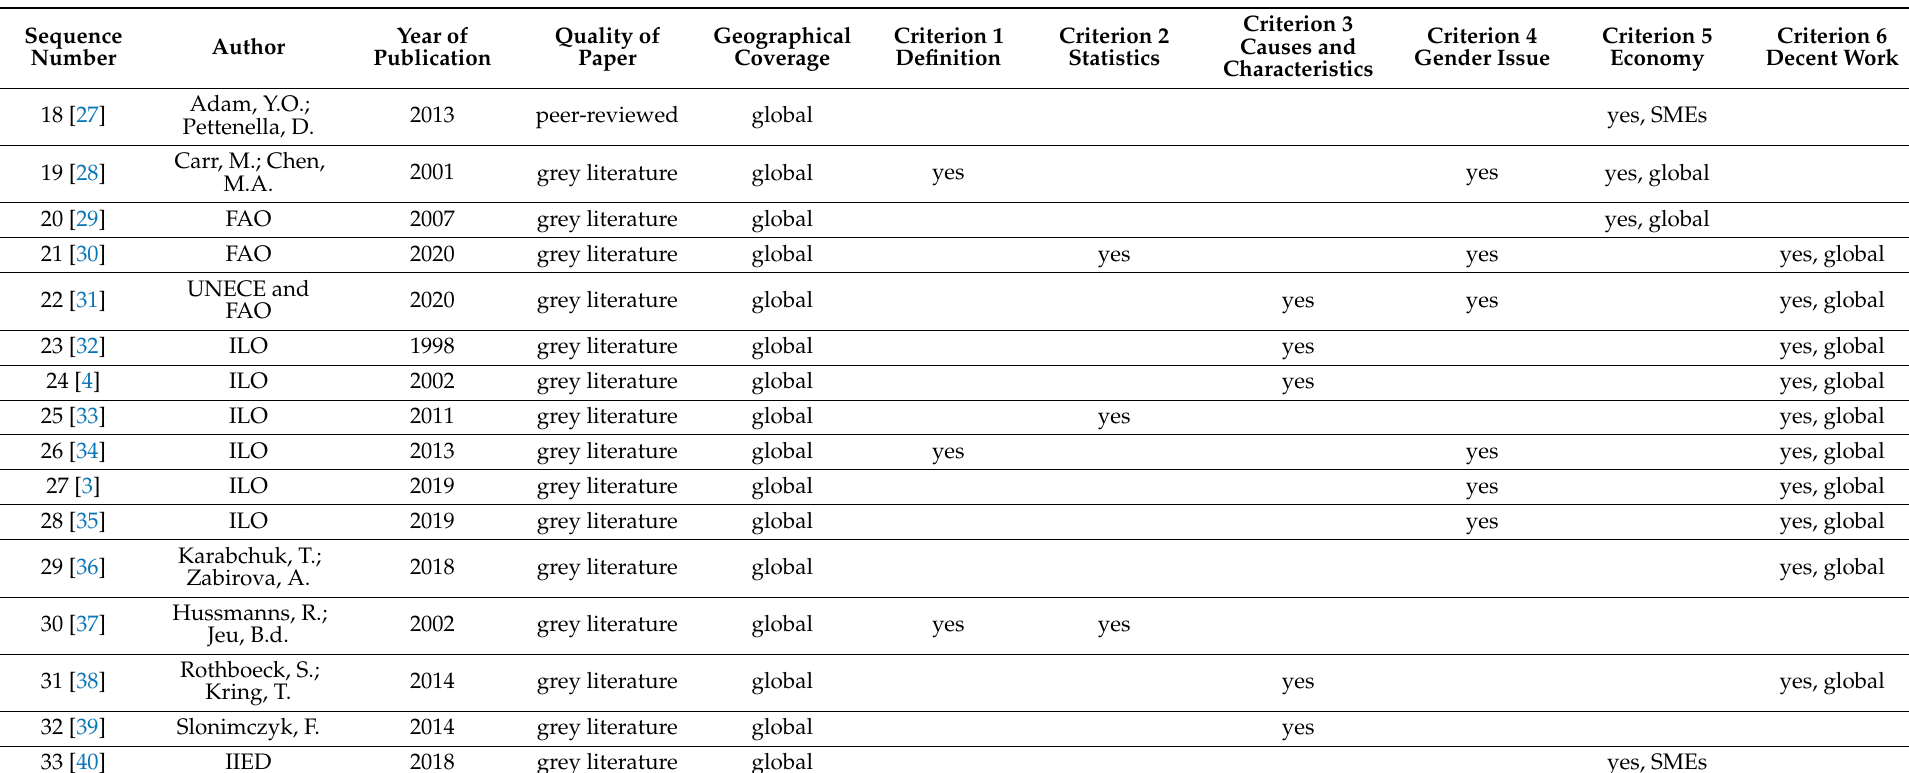
Table 2. Eligible literature from backward